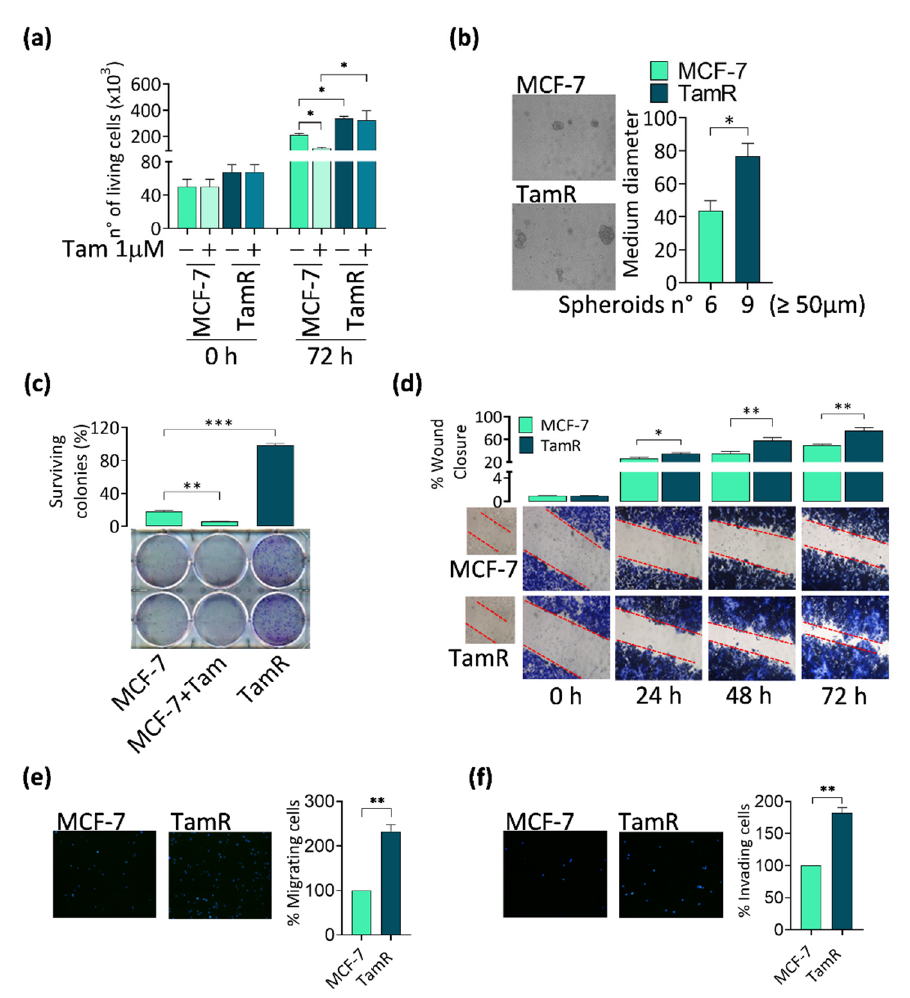
Figure 1. Comparison of tumor progression hallmarks in parental and TamR-derived BCCs. ( a ) Proliferation rate, ( b ) spheroids and ( c ) colony-forming potential, ( d ) wound-healing ability, as well as ( e ) motility and ( f ) invasivity have been compared in parental MCF-7 and the derived TamR cell line (refer to Section2 for experimental procedures). Results represent the mean ± s.d. of at least three independent experiments (* p ≤ 0.05, ** p ≤ 0.01, *** p ≤ 0.001).